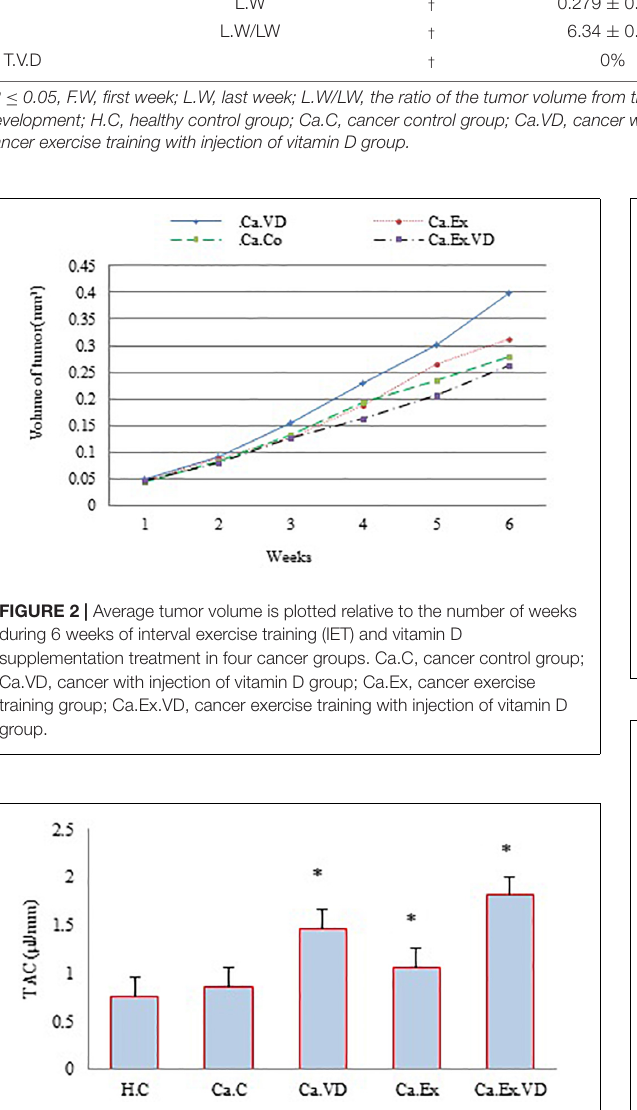
expression of all three genes in cardiac tissue, while a lower of vitamin D except Mfn-1 gene.